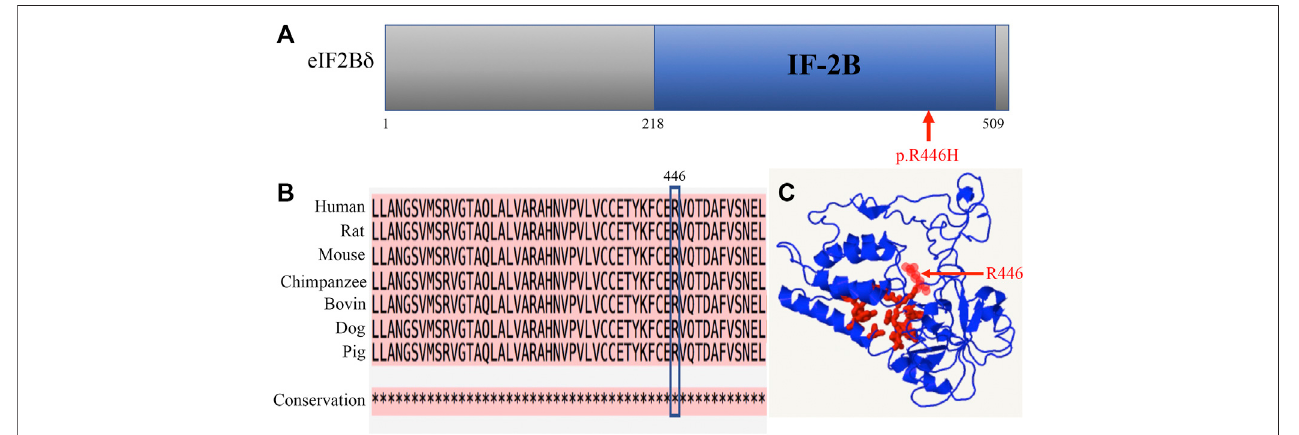
FIGURE3| AminoacidR446ishighlyconservedamongmammals. (A) LocationoftheR446HmutationintheeIF2B δ protein. (B) Aminoacidsequencealignmentsacross species indicate high conservation around residue R446. * fully conserved. (C) 3D structural prediction of the eIF2B δ protein. Red: pocket; red arrow: residue R446.